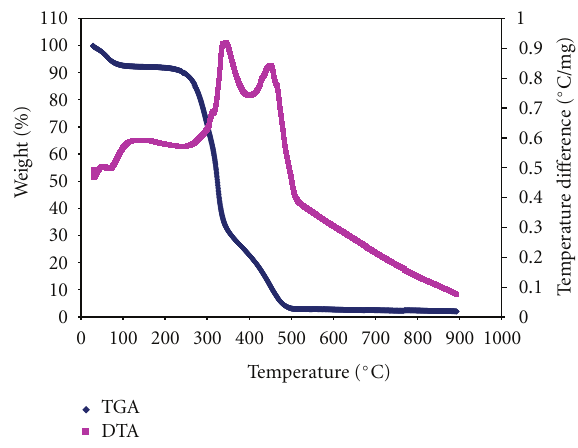
Figure 2: Thermograph of sugar cane bagasse.